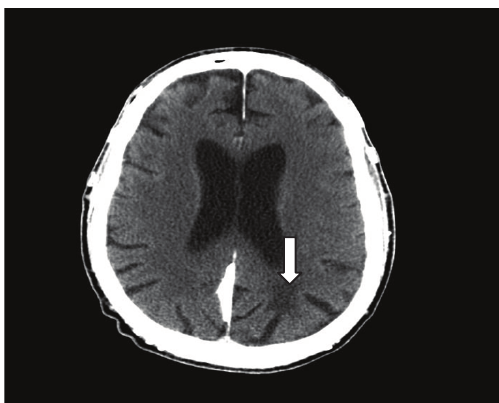
Figure 1: Nonenhanced CT scan shows a hypodensity in the left parietal